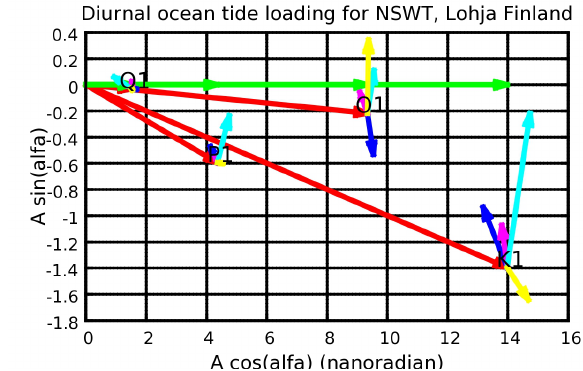
Figure 3: Green vectors along horizontal axis indicate theoretical model tilt (vector lengths are nanoradians from origin) with zero phase angle in complex plane. Red vector length indicates observed tilt amplitude and observed phase angle (alfa) indicated between horizontal axis and observation vector respectively (phase angle positive counterclockwice and negative clockwice). Ocean loading